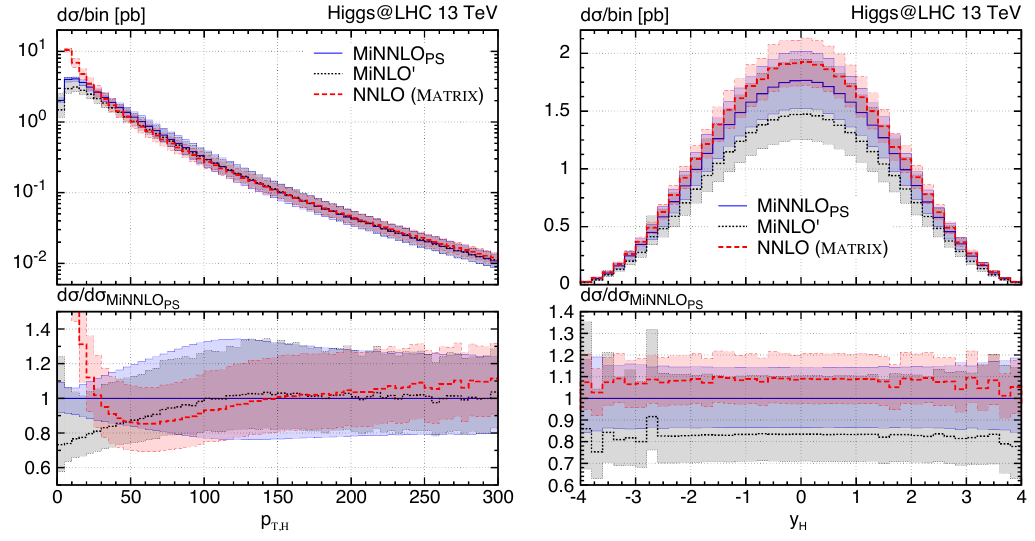
Figure 2 . Distribution in the transverse momentum (left) and rapidity (right) of the Higgs boson for MiNNLO PS (blue, solid), MiNLO 0 (black, dotted), and NNLO (red, dashed).